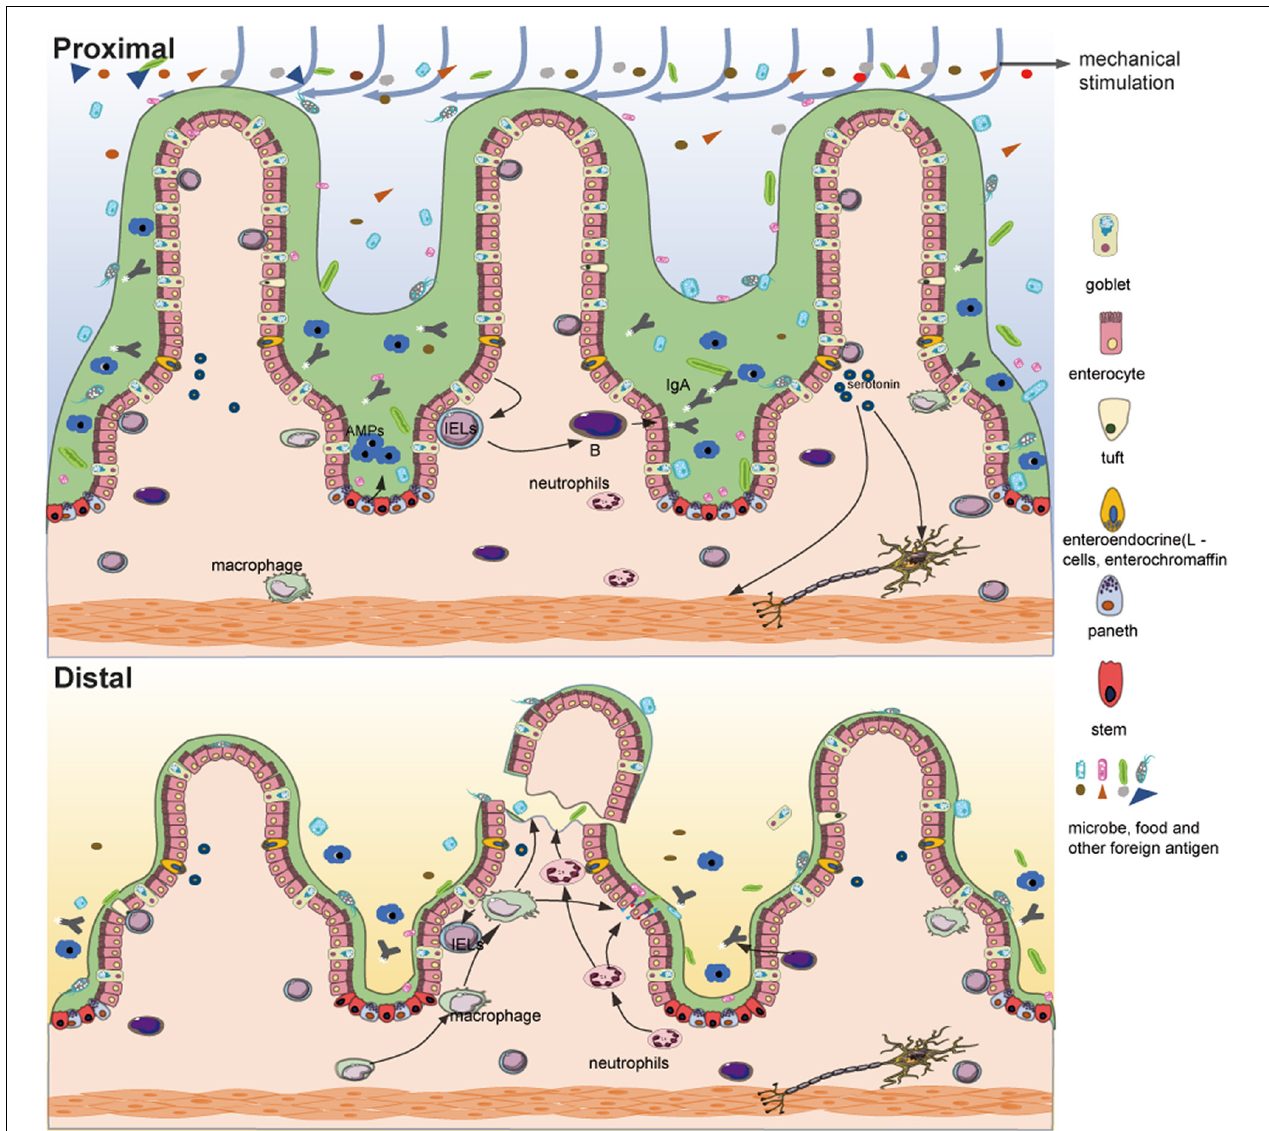
FIGURE 2 | Differences between the functional proximal intestinal segment and the non-functional distal intestinal segment of an ileostomy. Compared with the proximal intestinal segment, fragile and atrophic intestinal villi, a significantly reduced number of goblet cells, thinned mucus layer, decreased Paneth cells with fewer antimicrobial peptides (AMPs), reduced mucosal bacterial load and microbial diversity, decreased intestinal interepithelial lymphocytes, aggregated innate immune cells (such as neutrophils), atrophic muscular layer and possible reduction of serotonin are shown in the distal intestinal